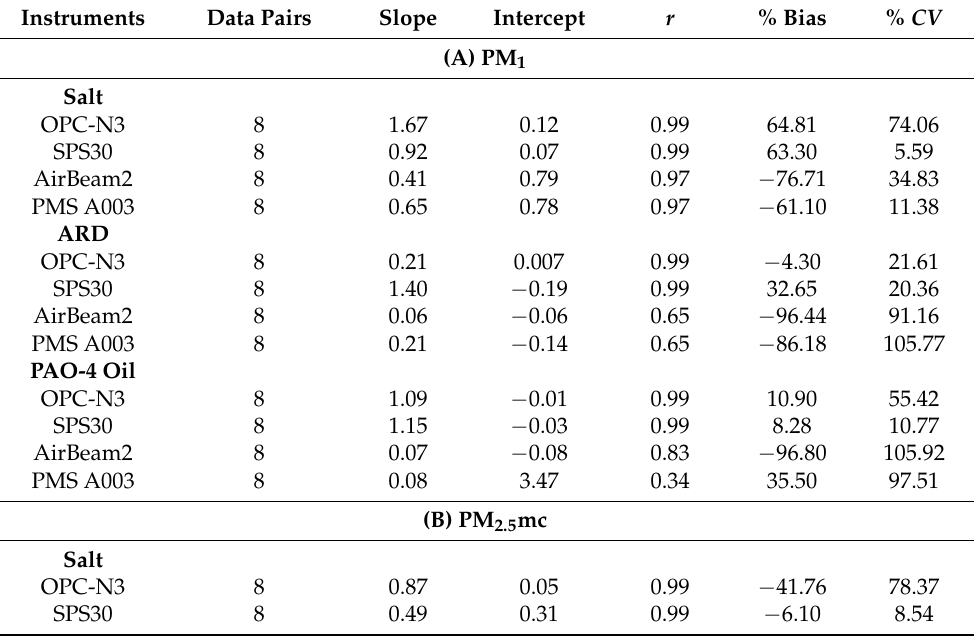
Table 2. Evaluation of mass concentrations reported by the sensors compared with the reference instrument for (A) PM 1 , (B) PM 2.5 mc, and (C) PM 10 for environmental concentrations. EPA and percentage = ±10% (NIOSH only).